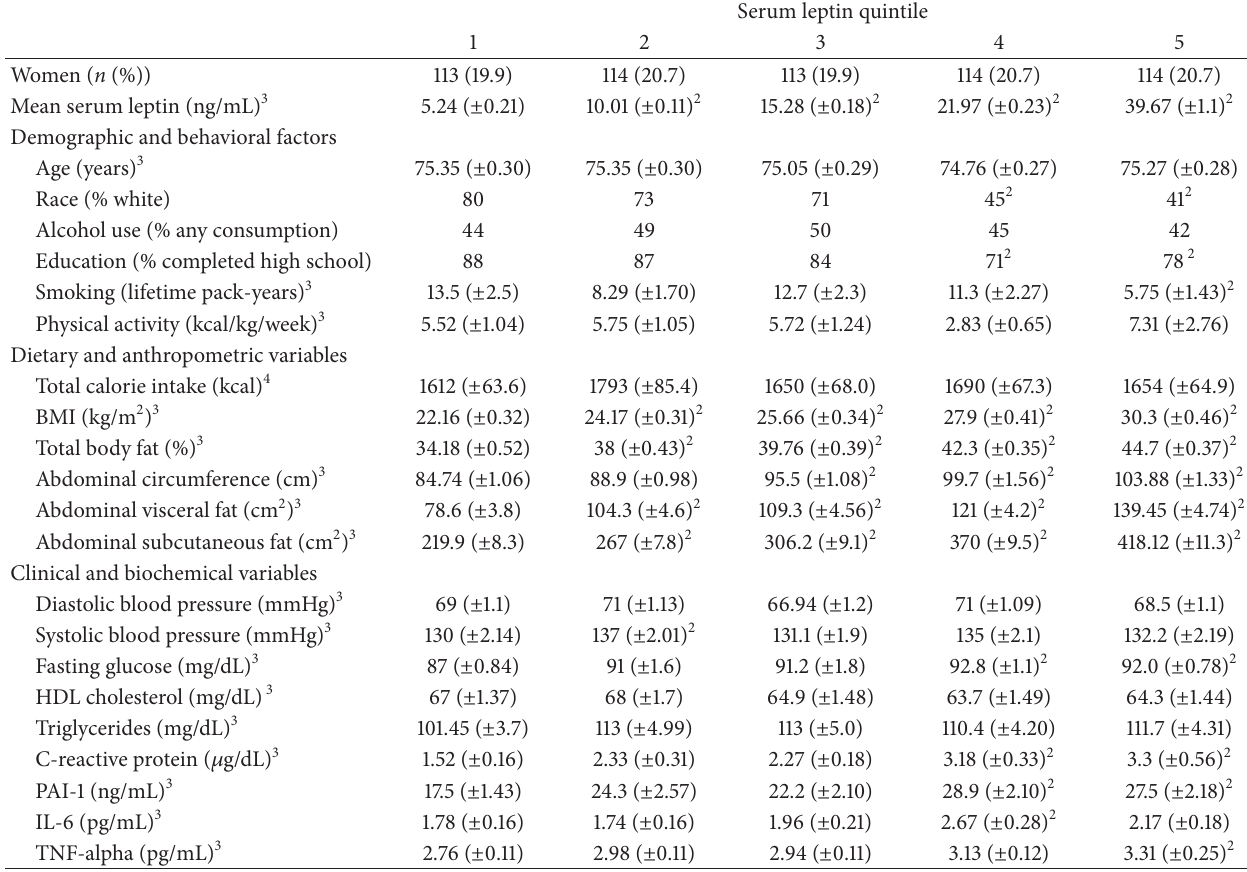
Table 2: Baseline characteristics of women by serum leptin quintile 1